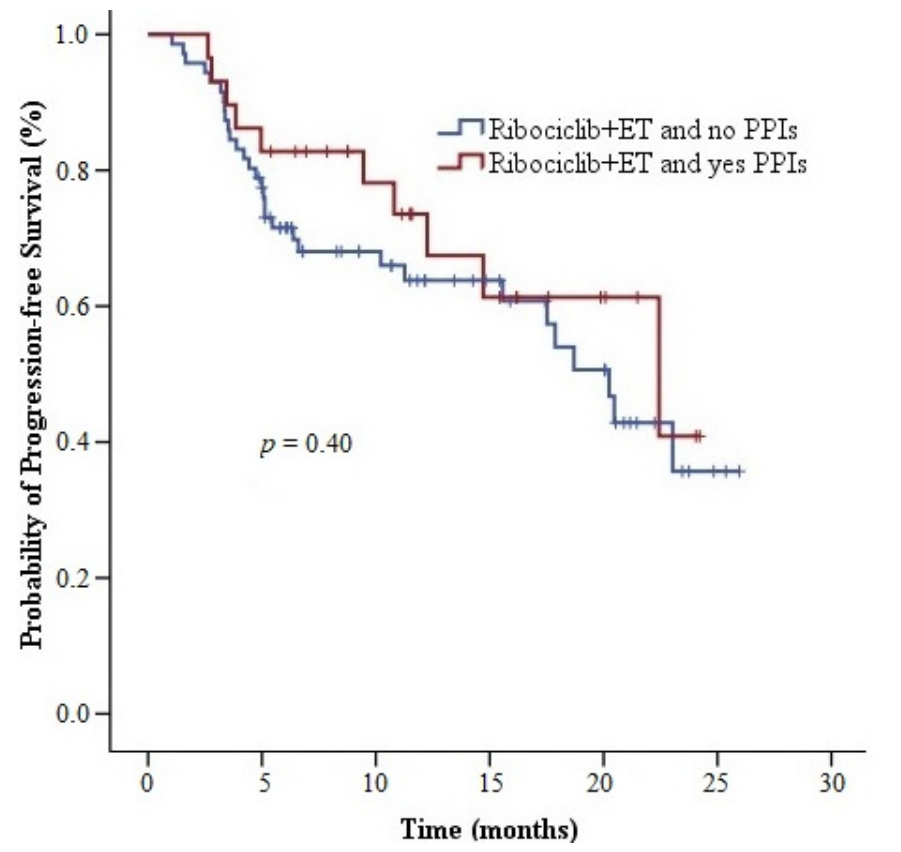
Figure 3. Progression-free survival curves of ribociclib + endocrine therapy with or without proton pump inhibitor. Abbreviations: ER, estrogen receptor; PPI, proton pump inhibitor.